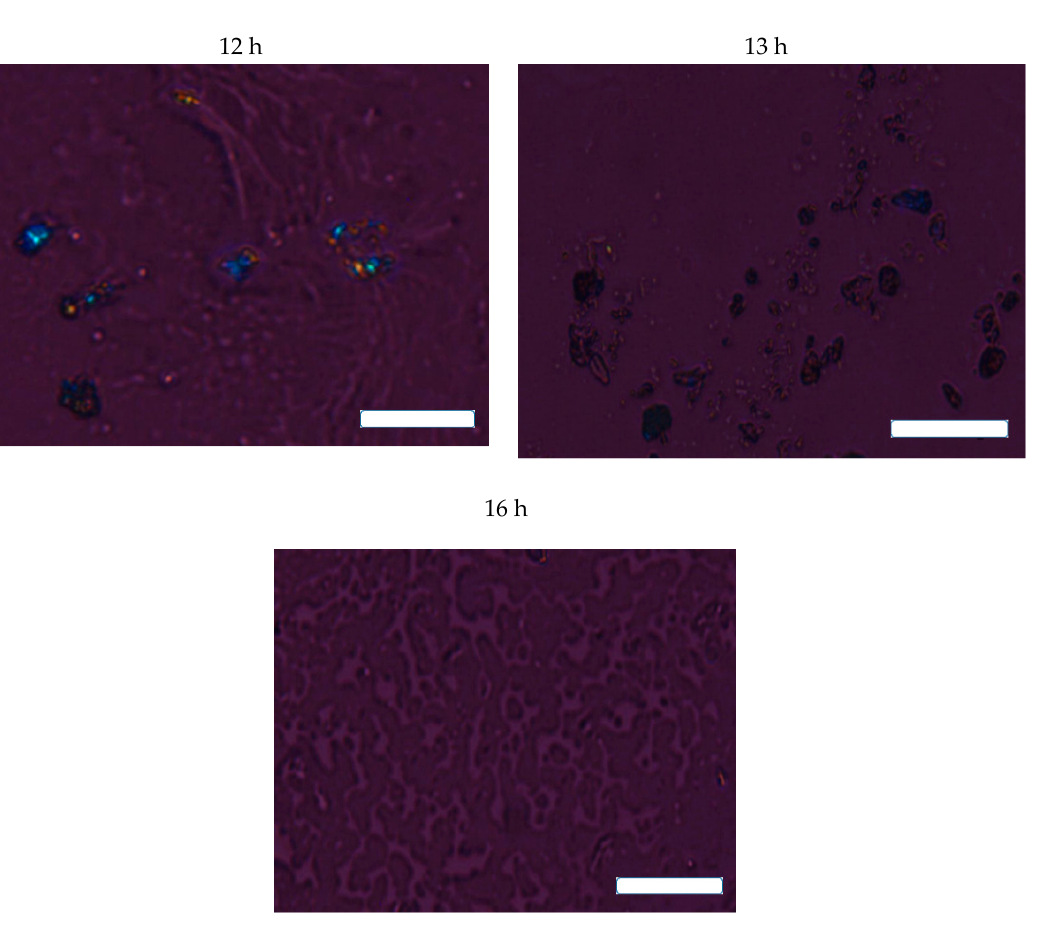
Figure 6. Polarized light microscopy images G4-F NG samples after different irradiation times. Scale bar = 50 μ m.